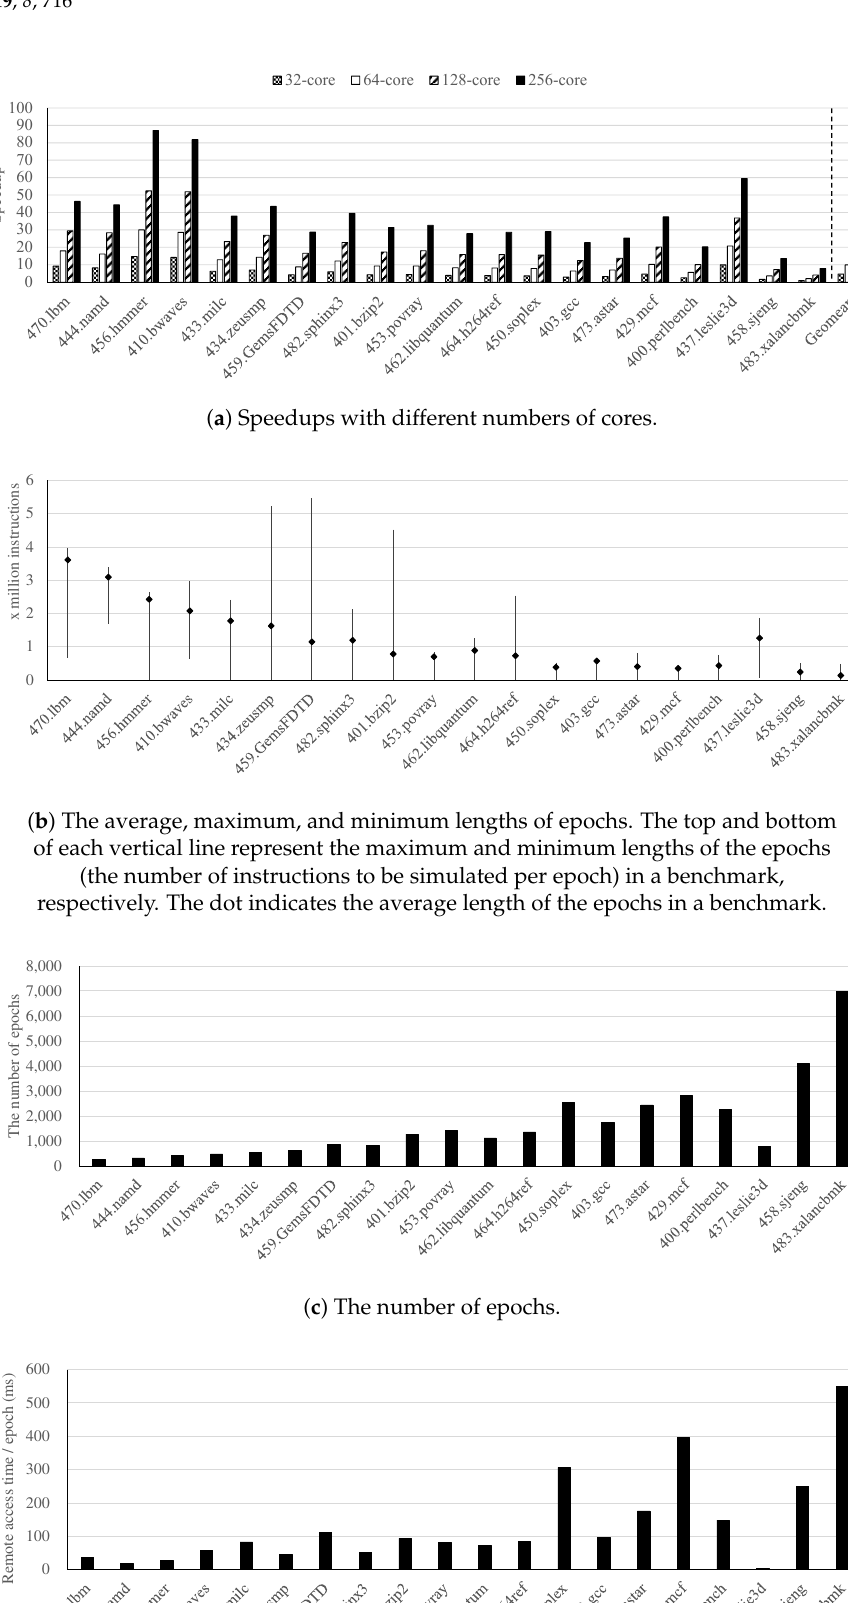
( c ) The number of epochs.